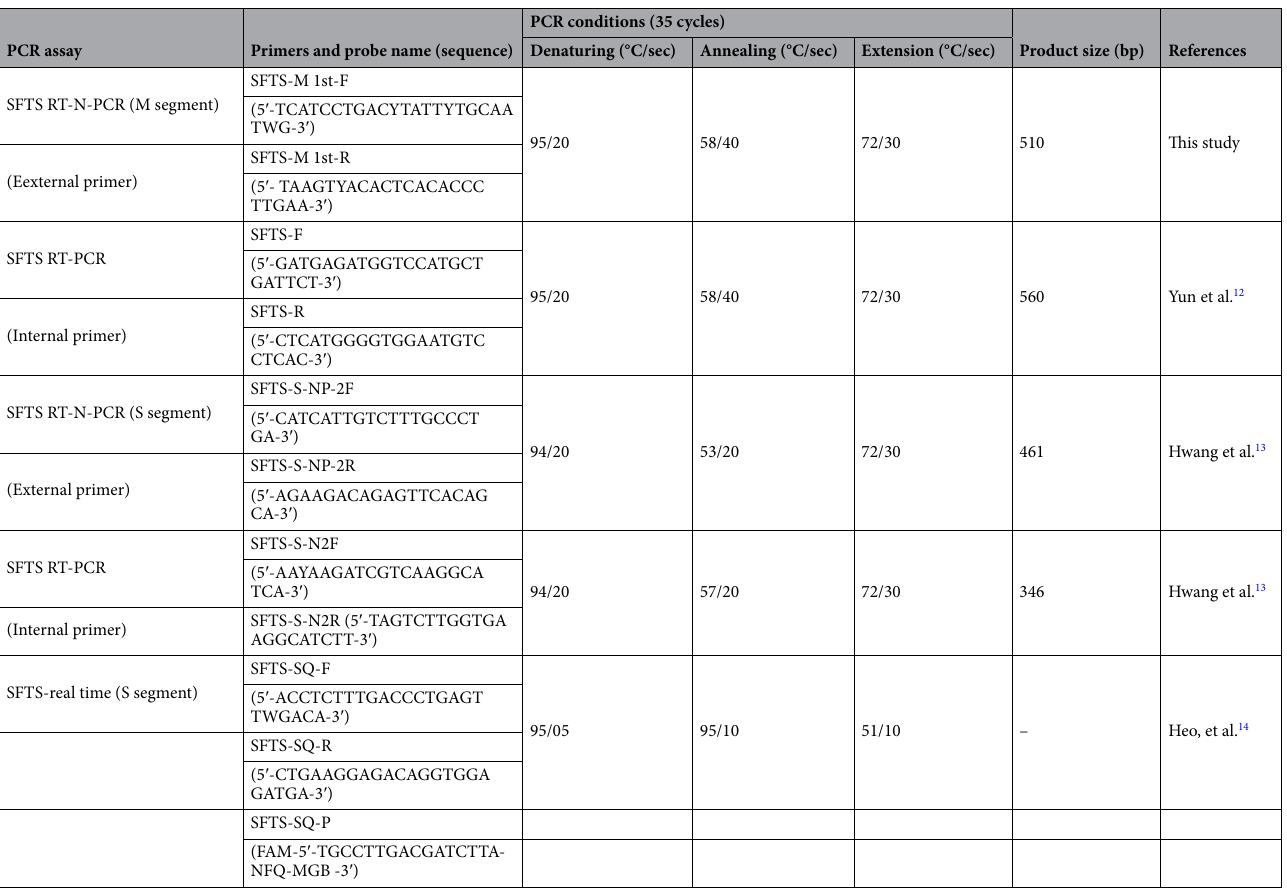
Table 3. Oligonucleotide primers, probes, product base pair (bp) size and conditions used for polymerase chain reactions (PCR) conducted in this study for the detection of severe fever with